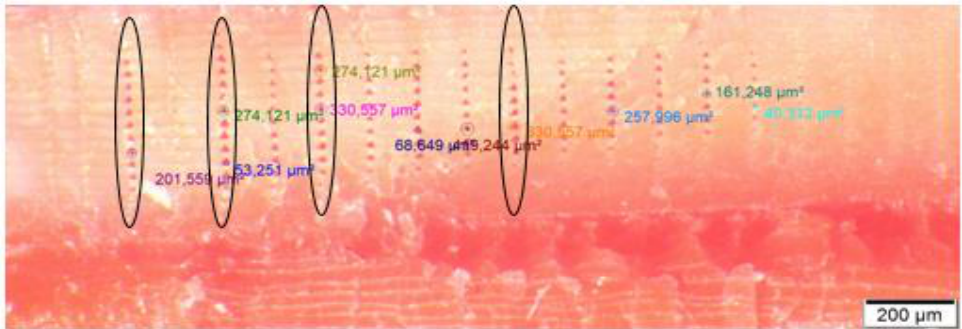
Figure 11. The cross-sectional image of a specimen that was broken while being 3D printed using FDM in a 5-bar nitrogen environment.